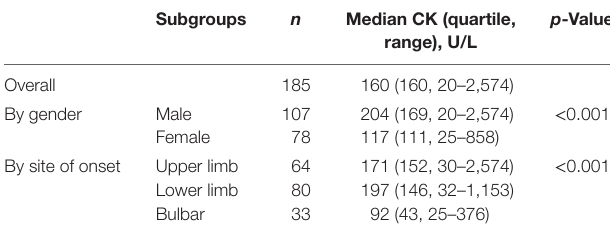
Table 1 | Serum creatine kinase (CK) levels of patients in different gender and site of